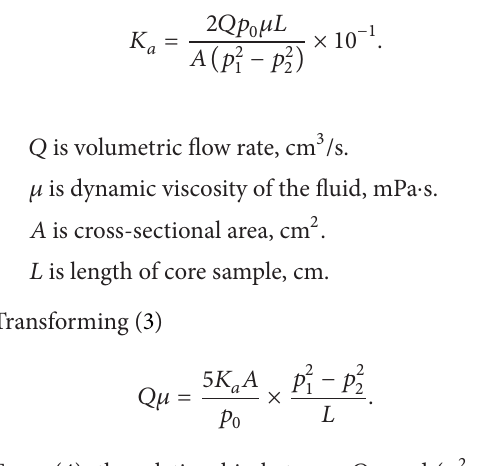
Figure 2: Relationships between porosity and permeability at 3 MPa for core